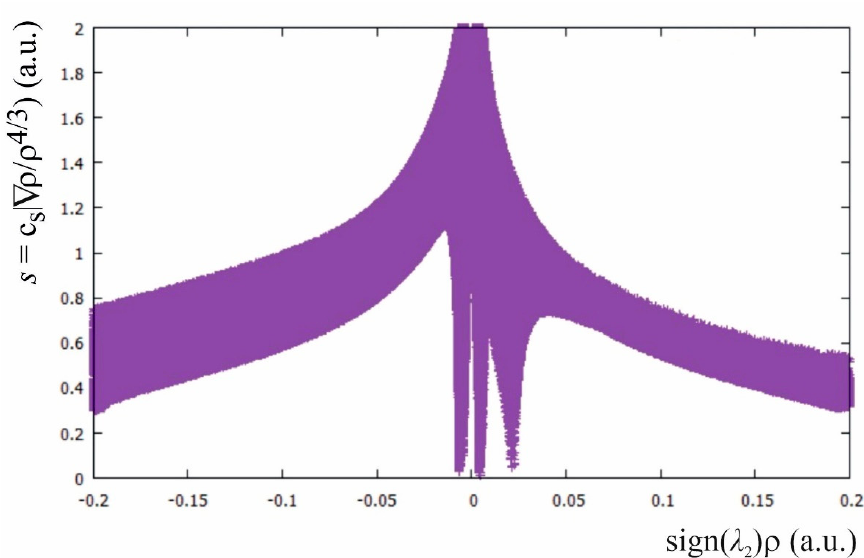
Figure 8. NCI diagrams for ( a ) acridine–fenamic acid, ( b ) acridine–flufenamic acid ( 1 ), ( c , d ) acridine–mefenaic acid ( 2_ stack1, 2_ stack2, Table 4) and acridine–tolfenamic acid (( e , f ) 3_ stack1, 3_ stack2, Table 4). three aromatic rings of acridine. For flufenamic acid–acridine complex, with two acridine